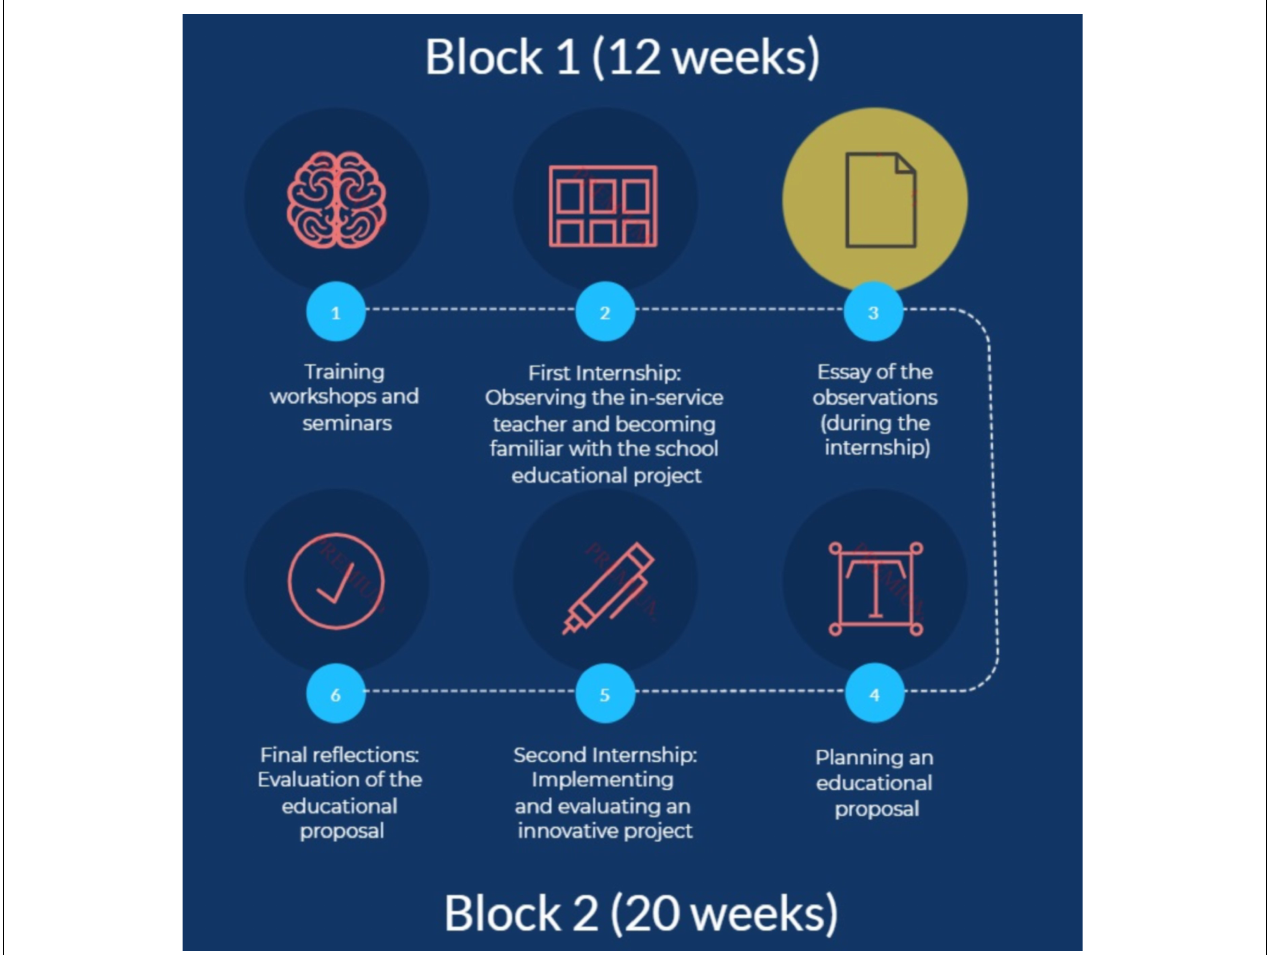
FIGURE 1 | Practicum process in the Master’s degree in Teaching in Secondary School at the